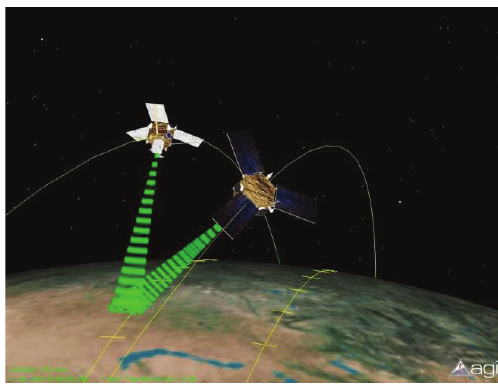
Figure 1: Stereoimaging